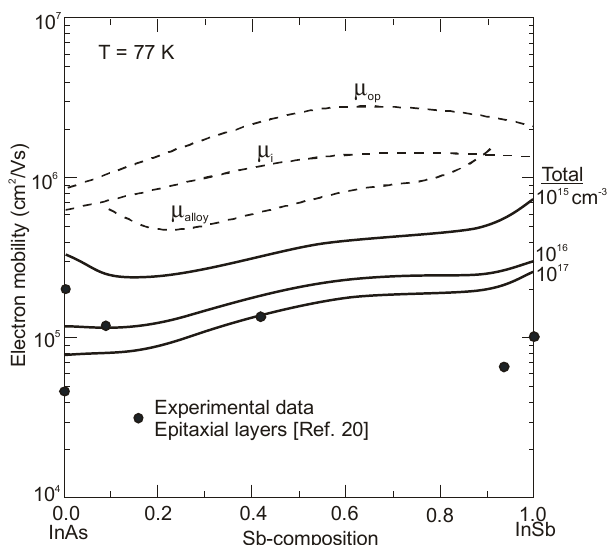
Figure 13. InAs 1–x Sb x mobility composition dependence at 77 K. The solid lines are the calculated mobilities for selected carrier concentrations, and the dashed lines are the component mobilities determined for a carrier concentration of 10 15 cm − 3 [77]. Experimental data is marked for epitaxial layers with carrier concentrations between 10 15 to 10 16 cm − 3 . Scattering legend: µ op -optical phonons, μ i -ionized impurity, μ alloy -alloy disorder.